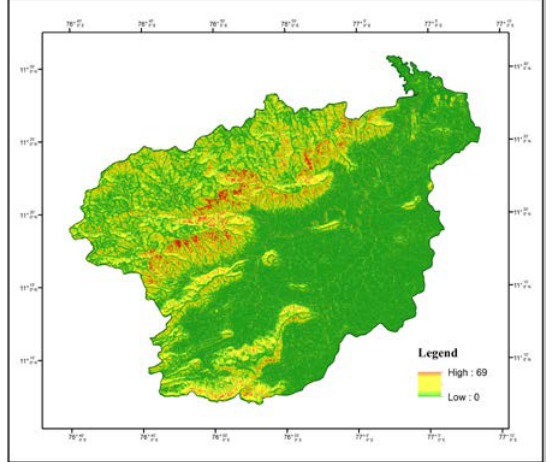
Figure 6. Slope Length and Steepnes (LS)